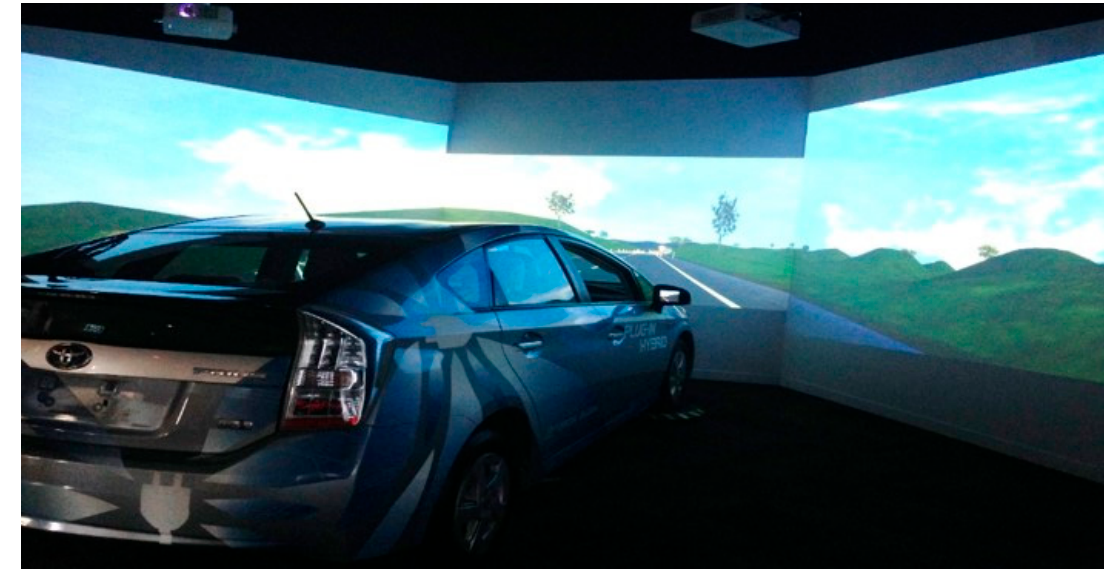
Figure 5. Transport Research Group driving simulator.